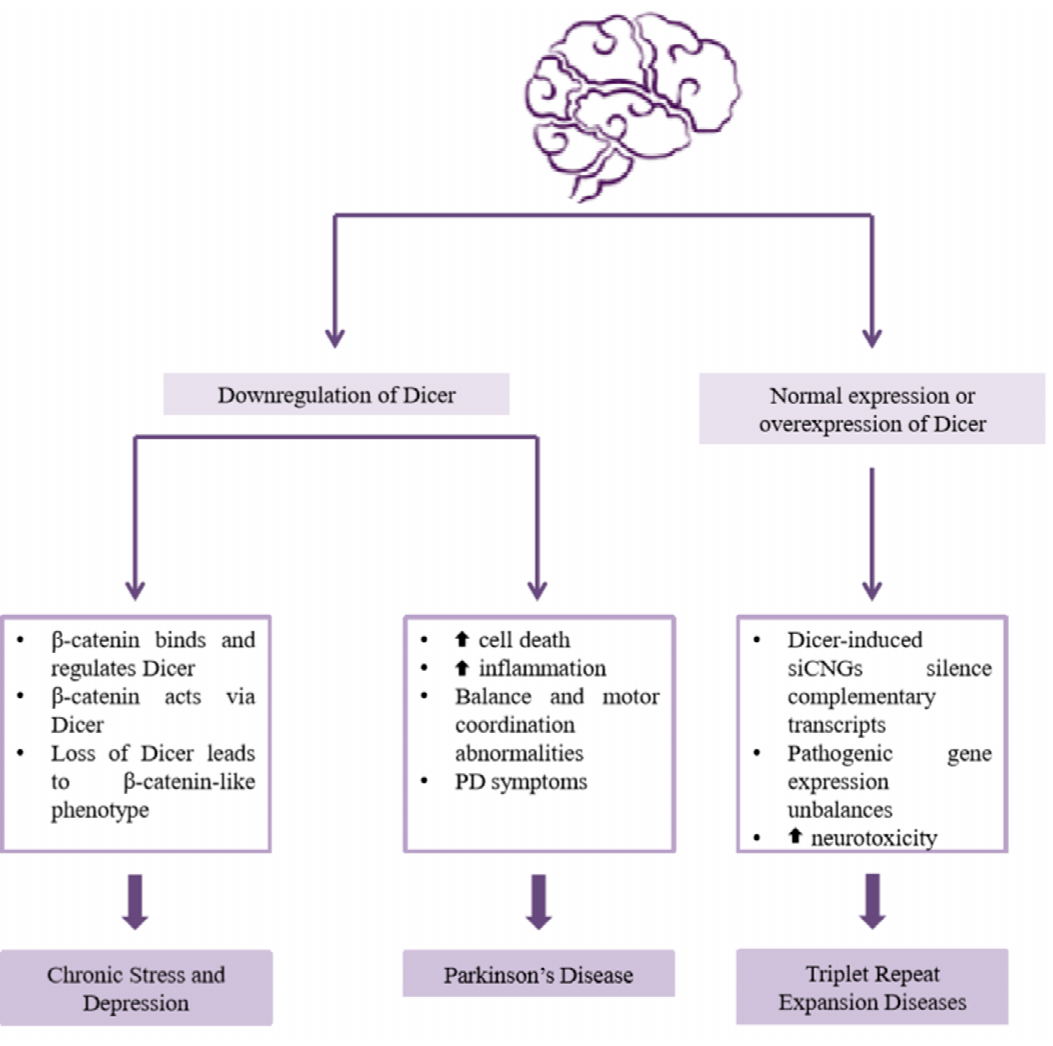
Figure 5. Dicer involvement in psychiatric and neurological diseases. Diagrammatic representation of the Dicer-associated neurological and neuropsychiatric disorders, as well as the typical pathways through which Dicer acts. Dicer downregulation can lead to the development of psychiatric and neurodegenerative diseases, such as depression and Parkinson’s disease, respectively, while the presence of Dicer enzyme may impair health of triplet repeat expansion disease (TRED) patients.